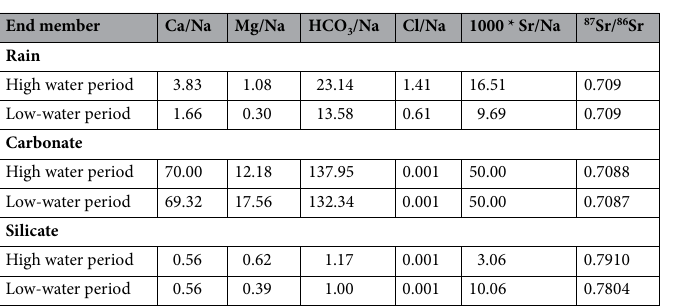
Table 8. End-member parameters of the